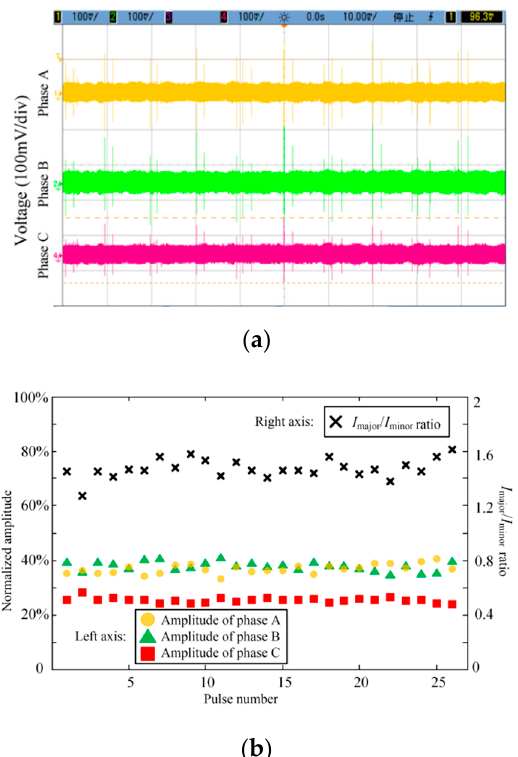
Figure 10. On-site partial discharge (PD) pulses in cables and their amplitude distributions. ( a ) PD pulses displayed on the oscilloscope. ( b ) Amplitude distributions of the detected PD pulses.